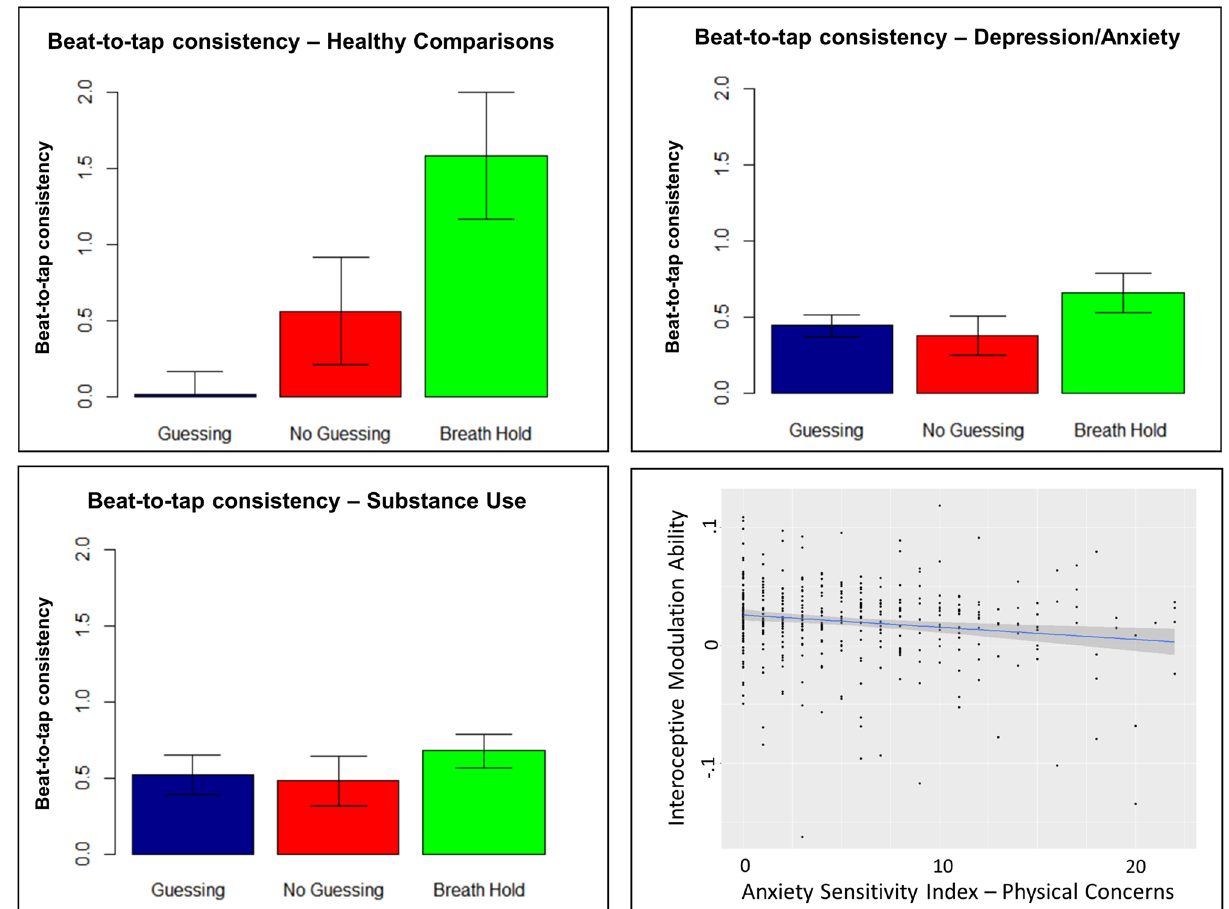
Figure 3. Bar plots showing the mean and standard error of beat-to-tap consistency by condition and group. There was an interaction between task condition and group, reflecting a pattern in which